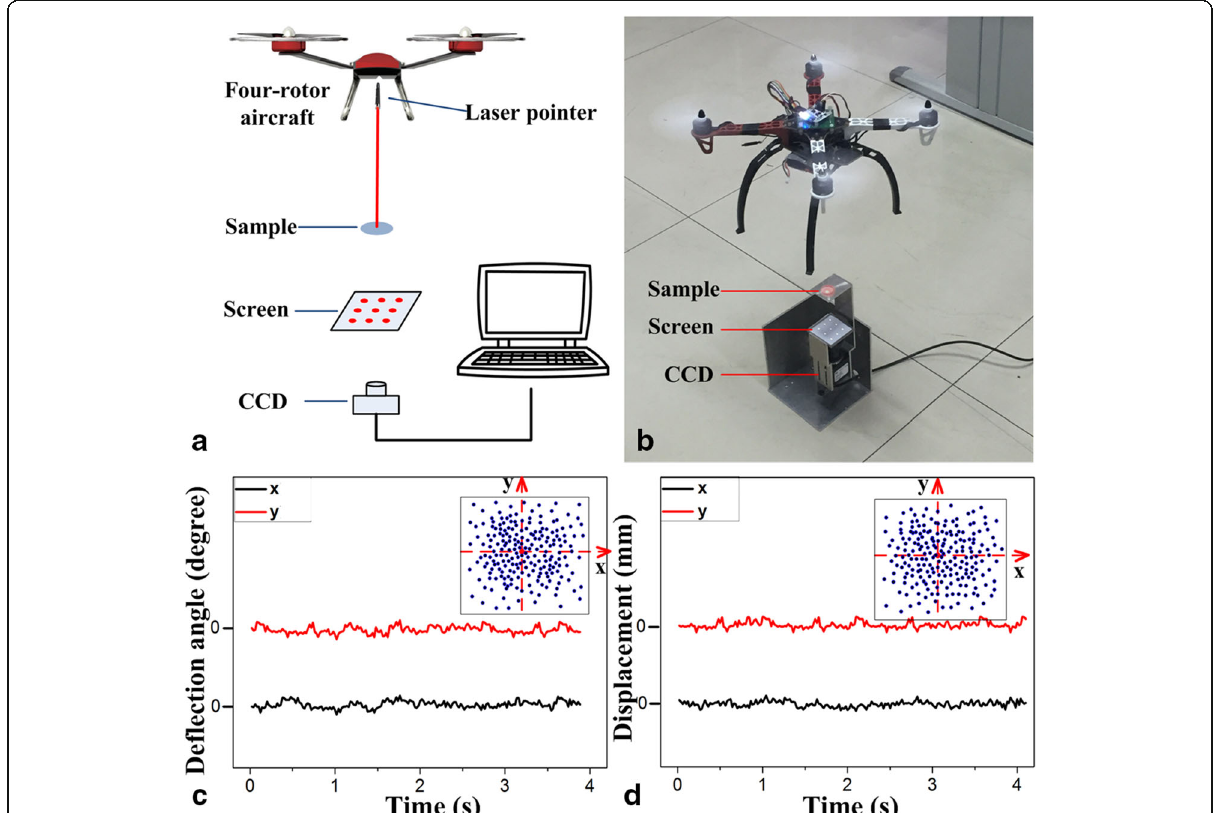
Fig. 5 Characterizations of four-rotor craft attitude. a System diagram. b Setup of system. c Angle of deflection of rotor craft. d Displacement of rotor